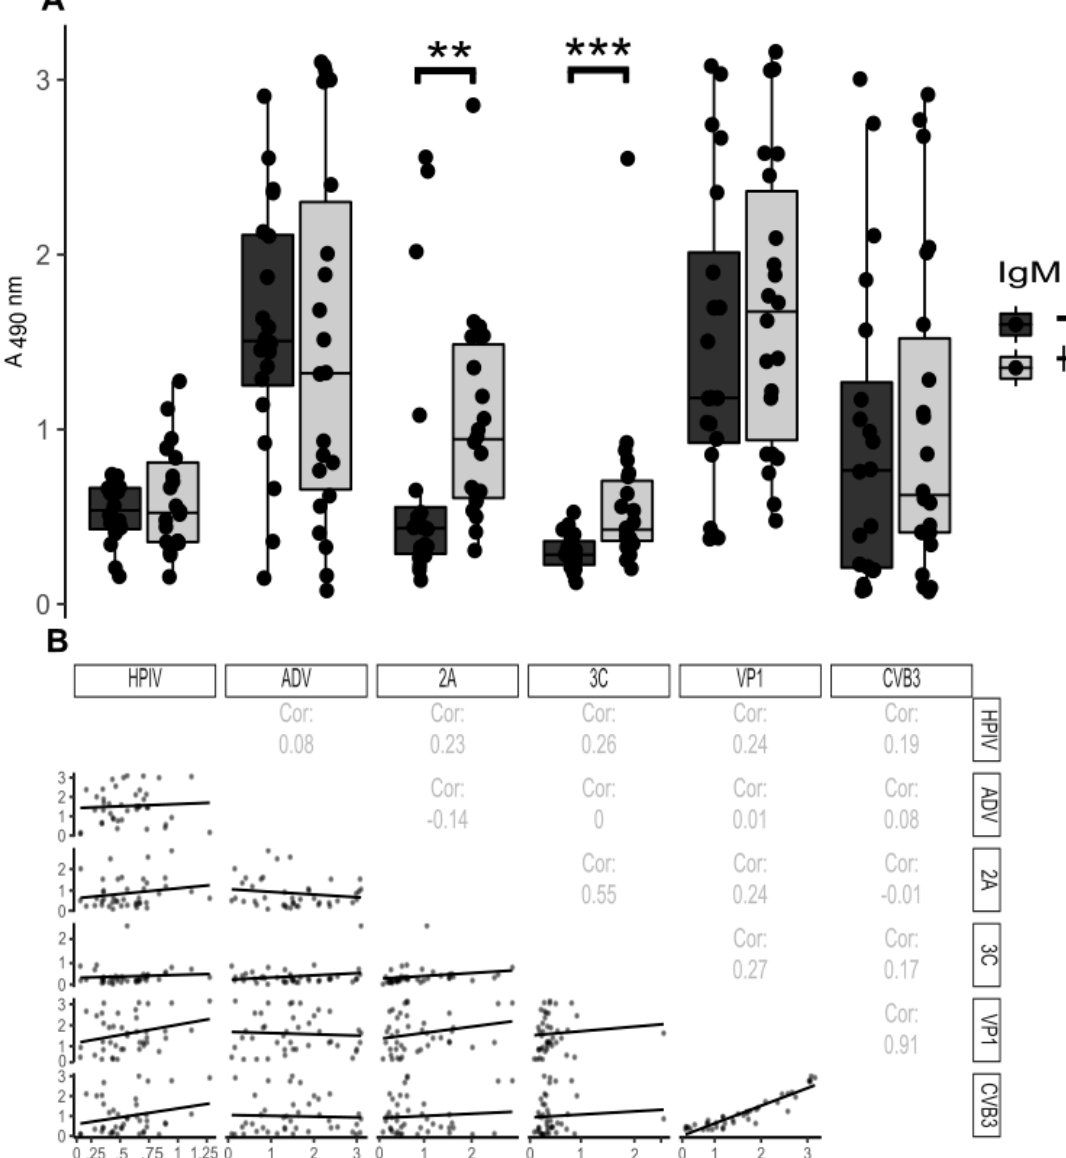
Figure 4. Antibody response towards viral proteins in acutely infected patients. Serum samples obtained from acutely infected humans with confirmed enteroviral infections (IgM positive, n = 22) and healthy controls (IgM negative, n = 20) were analyzed for immunoreactivity towards the indicated viruses or viral proteins. ( A ) Boxplot diagrams show the antibody responses towards di ff erent antigens analyzed using ELISA (serum diluted 1:1000) for acutely infected human patients (gray) and controls (black). ** p < 0.001 and *** p < 0.0001, two-tailed Wilcoxon signed-rank test analyzed in R. ( B ) The data set in A was used for creating a correlation matrix with pairwise comparisons. The top-right diagonal in panel ( B ) shows the Spearman correlation coe ffi cients of antigen pairs and the bottom-left diagonal shows pairwise scatterplots with linear regression trend lines. Abbreviations: HPIV, human Parainfluenzavirus; ADV, Adenovirus; 2A, CVB3 2A protease; 3C, CVB3 3C protease; VP1, CVB3 VP1; CVB3, heat inactivated whole Coxsackie B3 virus.